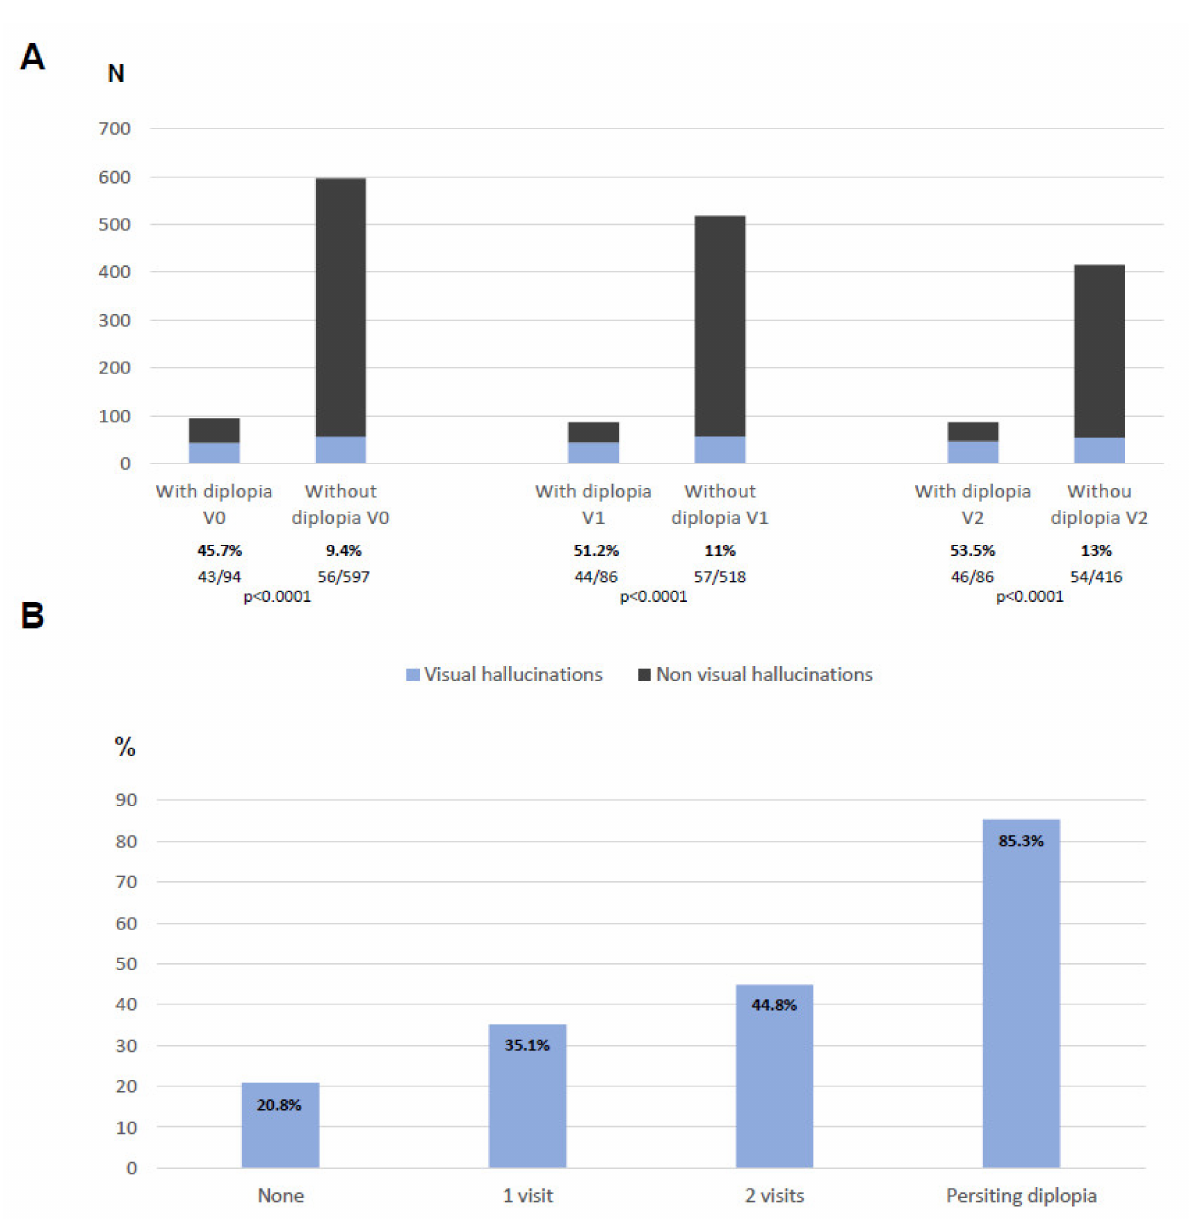
Figure 2. ( A ) Number of patients reporting visual hallucinations at V0, V1, and V2 when they were divided in patients with vs. without diplopia. ( B ) Percentage of patients reporting visual hallucinations at least once during the follow-up according to the times who reported